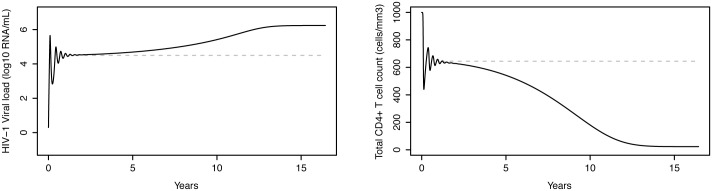
Evolution of plasma HIV-1 RNA levels and CD4+ T cell counts in an untreated subject.Left: Plasma HIV-1 RNA levels as a function of time, simulated by the HIV-D model accounting for disease progression. Right: corresponding CD4+ T cell counts. The model simulates the 3 typical stages of HIV-1 infection: acute infection, clinical latency and AIDS phase. Dashed grey lines represent the HIV-D model without disease progression, the stable-state solution of which is exploited to introduce between-patient variability in plasma cell concentrations.